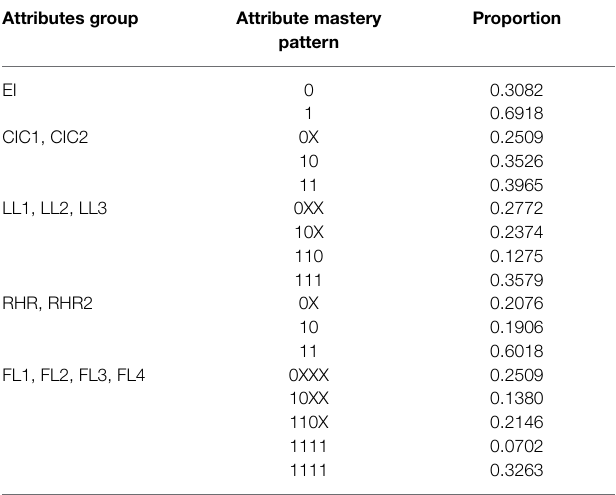
TABLE 6 | Classification results. Attributes group Attribute mastery